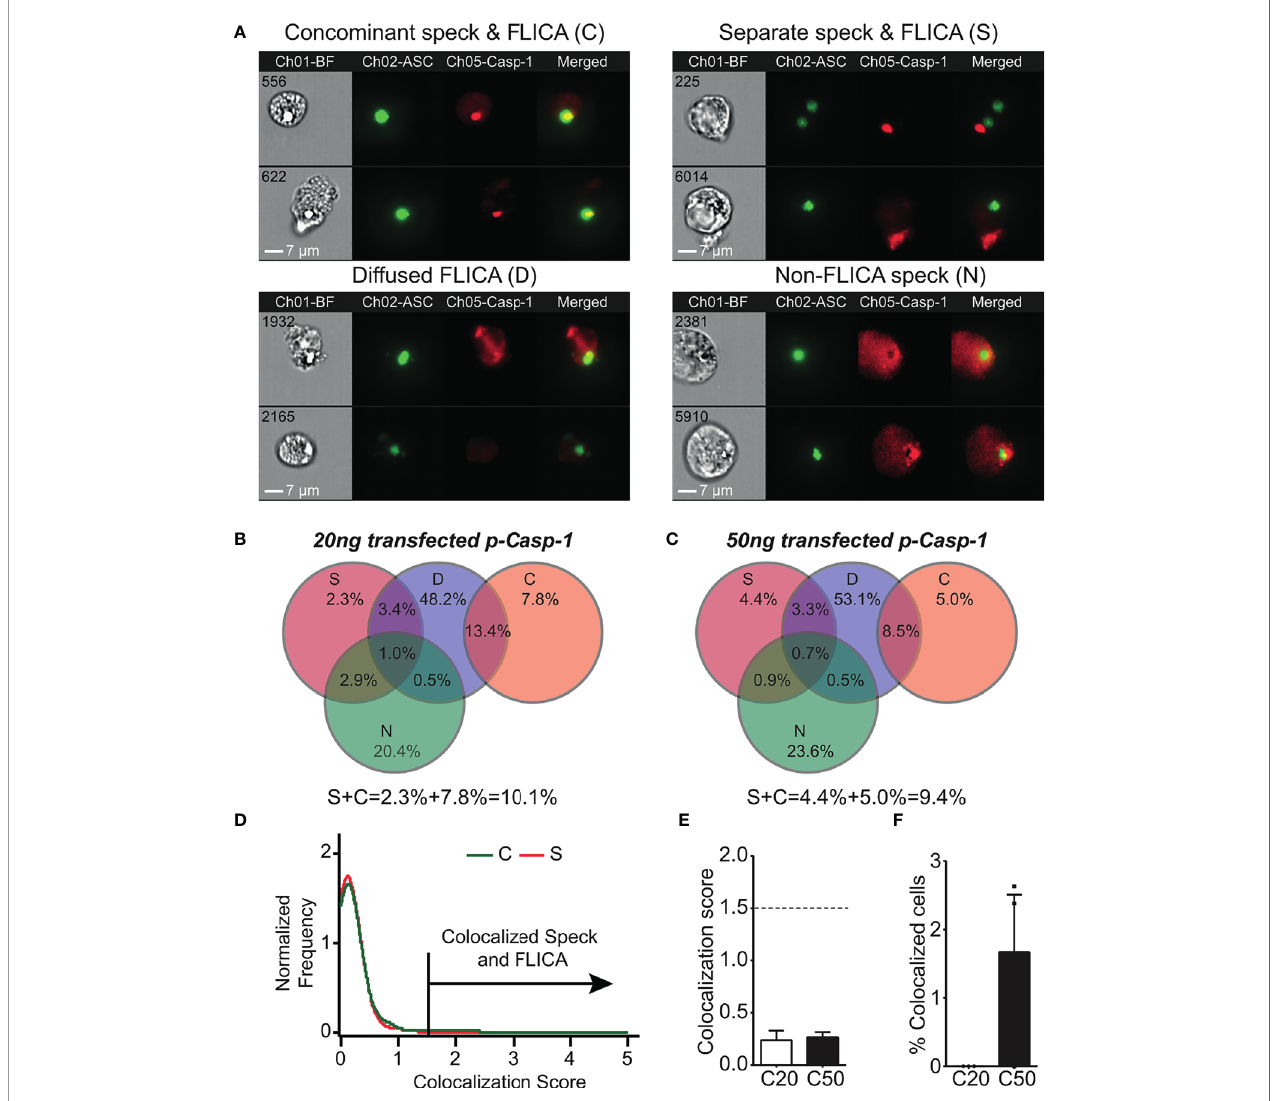
FIGURE 2 | Active caspase-1 does not colocalize with the ASC speck. HEK293T cells were transfected with 100 ng NLRP3, 50 ng GFP-ASC, and 20 or 50 ng CASP1 and treated with 5 µm nigericin for 2 h. ASC speck-positive cells were analyzed for distribution of active caspase-1 and ASC speck by in fl ammasome and caspase-1 activity characterization and evaluation (ICCE). Ch01-BF (bright fi eld), Ch02-GFP-ASC (green), Ch05-active caspase-1 (FLICA; red). The cells containing specks and active caspase-1 were manually segregated into four different subpopulations. (A) Representative images from the subpopulation of cells showing (top left) coincident ASC speck and active caspase-1 (C) , (top right) distant ASC speck and active caspase-1 (S), (bottom left) diffused active caspase-1 (D) , and (bottom right) specks lacking any detectable caspase-1 activity (N). The subpopulation of cells where active caspase-1 is diffused around the ASC speck. (B) Venn diagram showing the frequency of different subpopulations in cells transfected with 20 ng CASP1 (C20). (C) Venn diagram showing the frequency of different subpopulations in cells transfected with 50 ng CASP1 (C50). (D) Colocalization analysis of ASC speck and active caspase-1 of images shown in (A) (subpopulation C); histogram showing the threshold criteria for colocalization assay. (E) Mean colocalization score of images shown in (A) ; a threshold score of 1.5 was selected as positive for colocalization. (F) Frequency of colocalized events over total events noted above the threshold line for C20 (20 ng) and C50 (50 ng) amount of transfected CASP1. Data represented as mean ± SEM for a minimum of three independent experiments. Data represented as mean for (B)